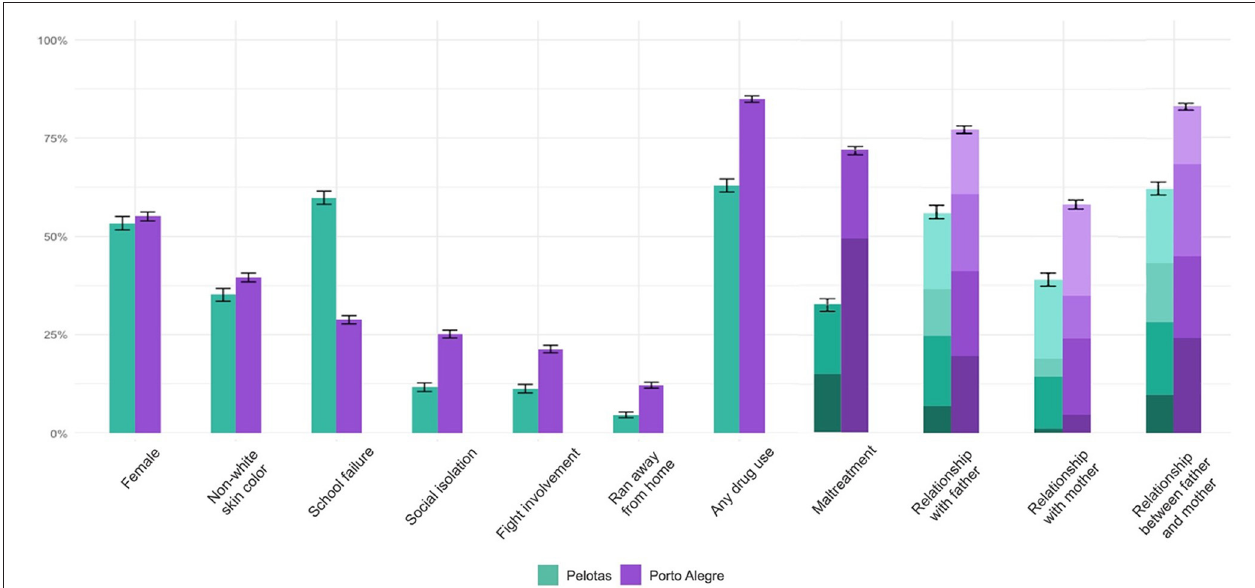
FIGURE 5 | Prevalence of risk variables in Pelotas (2008) vs. Porto Alegre (2018–9). Proportions do not reach 100% because the figure only shows responses that indicate risk for the variables (i.e., non-involvement in fights or non-use of drugs are not shown). 95% confidence intervals are shown in dichotomous variables. In ordinal variables darker shades (bottom) indicate greater severity. The maltreatment variable is divided into “severe” (darkest green or purple) and “probable,” while relationship variables are divided into “bad” (darkest green or purple), “regular,” “good,” and “very good.” n = 3,290 (Pelotas) and n = 7,229 (Porto Alegre) adolescents with complete Identifying Depression Early in Adolescence risk score (IDEA-RS)